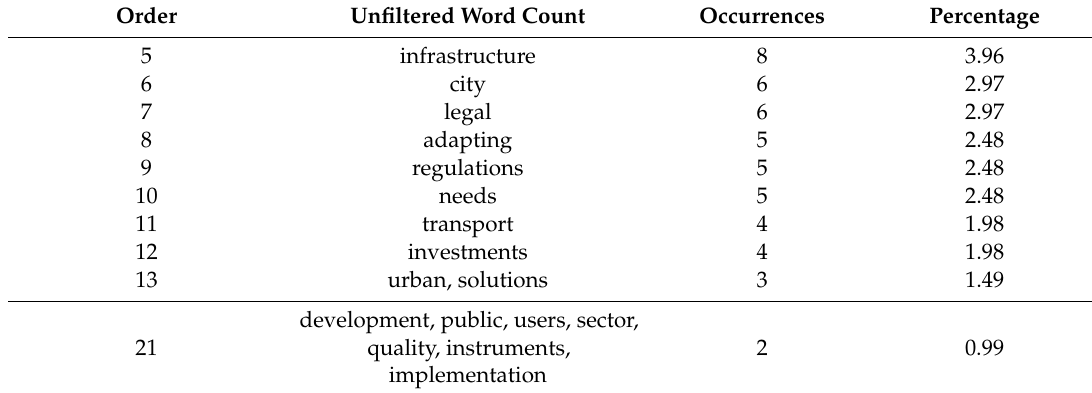
Table A6. Text mining results